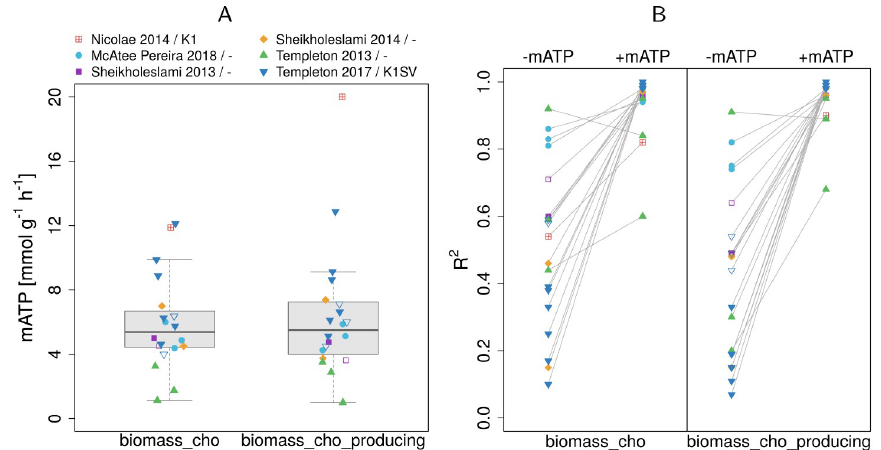
Fig 2. Estimated mATP values and their effect on flux prediction accuracy. (A) Computationally estimated mATP values for different datasets with two biomass equations. (B) R 2 values from linear fits of experimental and predicted intracellular fluxes without (-mATP) or with mATP (+mATP) as constraint. The legend indicates the publication and the used CHO cell line (if the information was available). Empty symbols indicate non-producers.